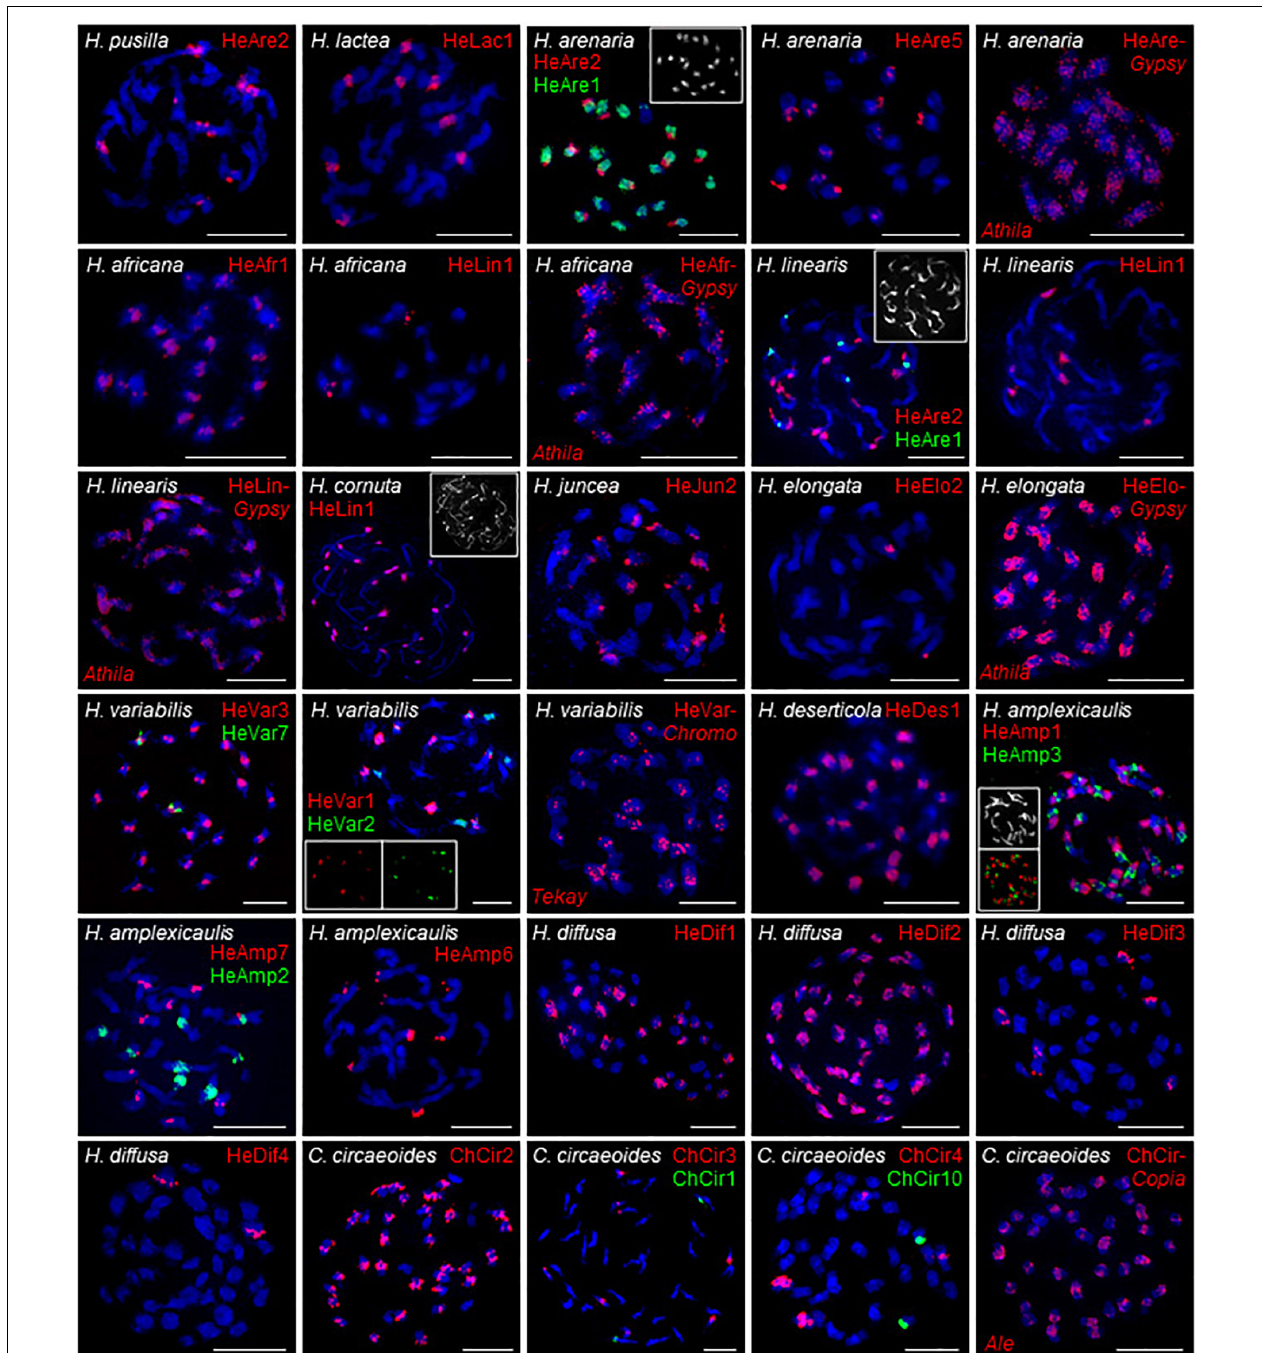
FIGURE 6 | FISH localization of the selected tandem repeats and retroelements on mitotic metaphase chromosomes of Heliophila species and C. circaeoides . Chromosomes were counterstained by DAPI; FISH signals are shown in color as indicated. Detailed information on the localized repeats is provided in Supplementary Table 6 . Scale bars, 10 µ